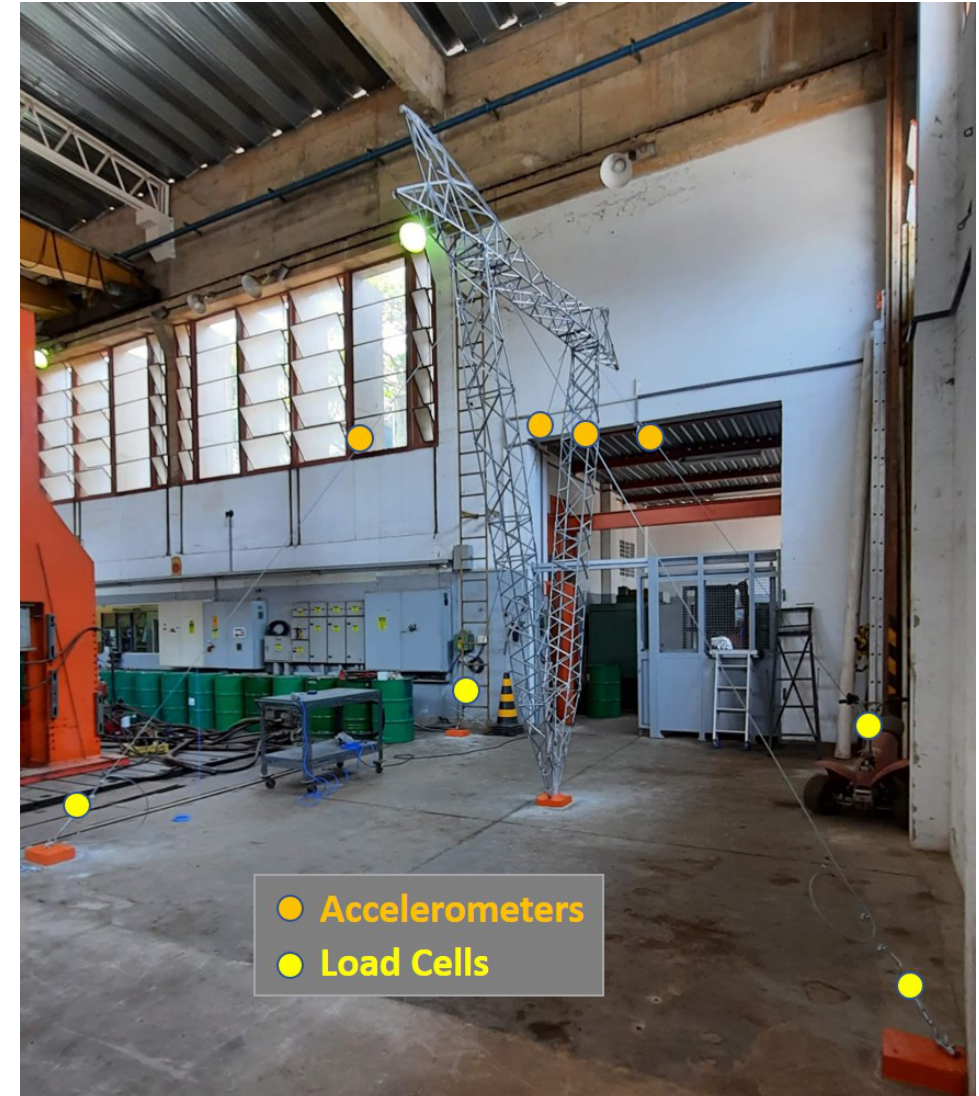
Figure 15. Structure of the stay cable tower assembled in LabEDin .